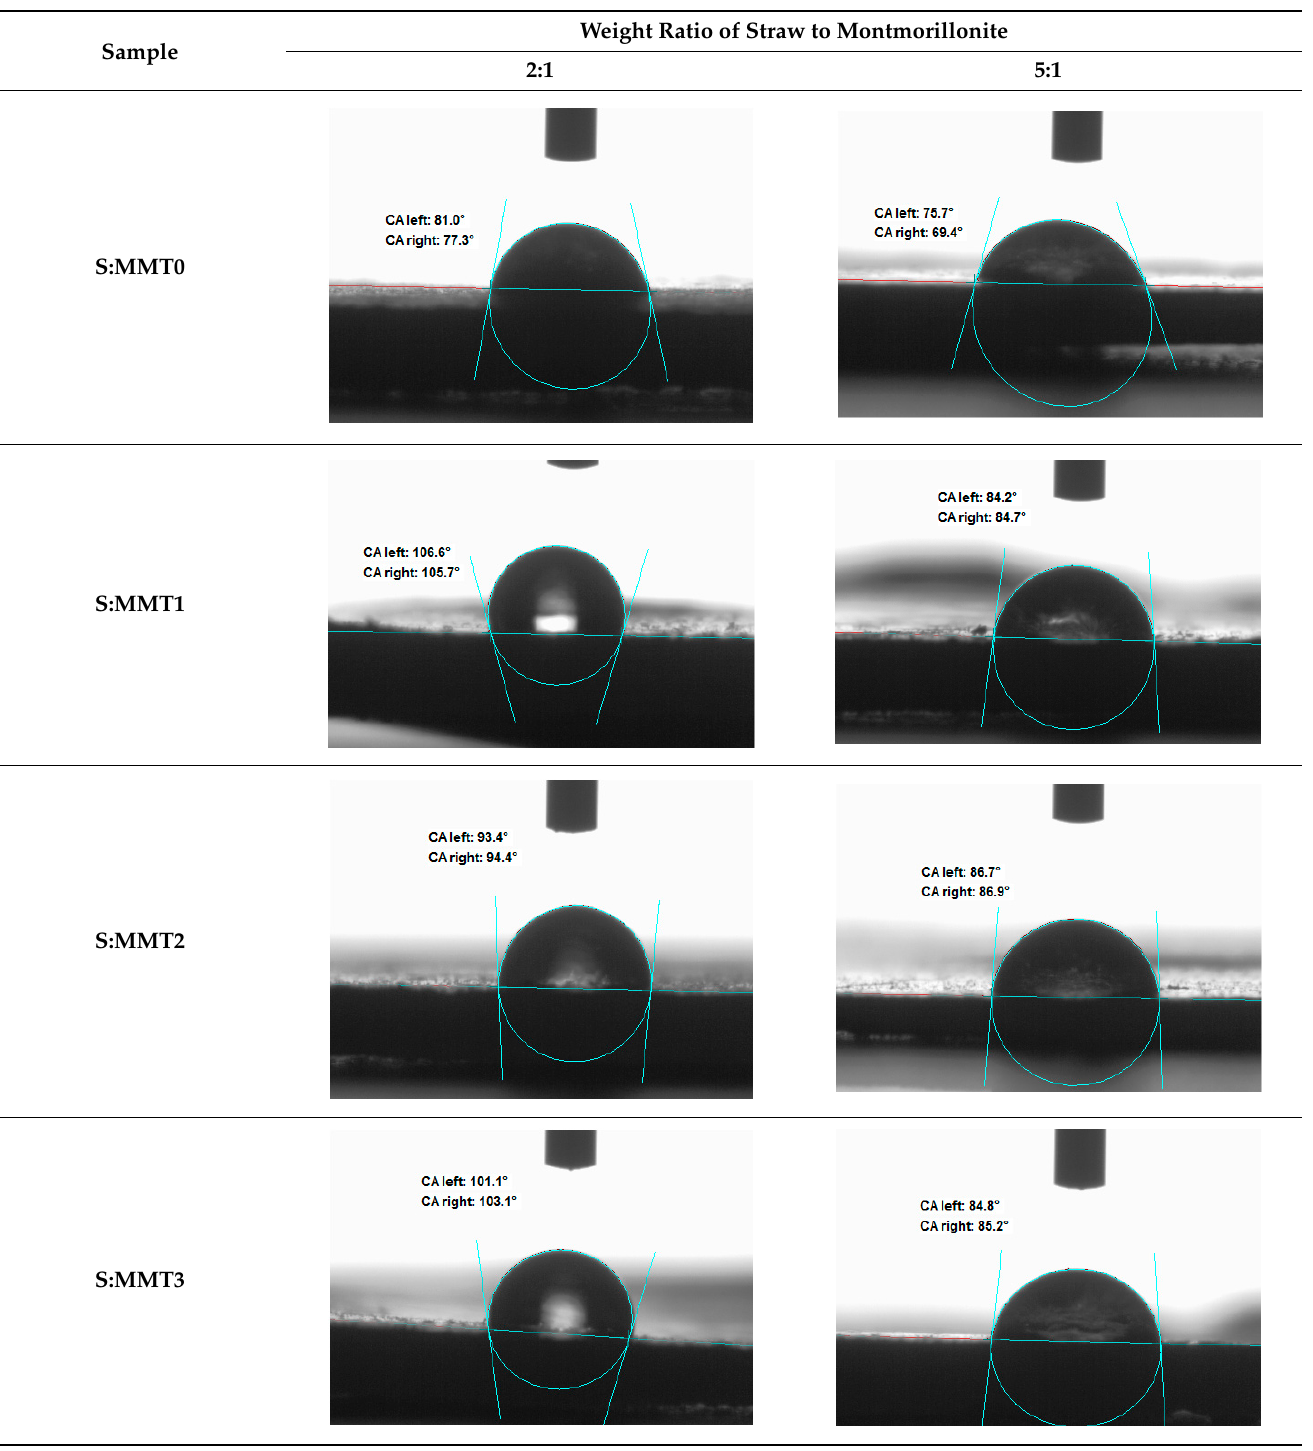
Table 3. Images of water drops on the surface of pressed fillers with determined contact angles (CA), standard deviations CA ± 5°.